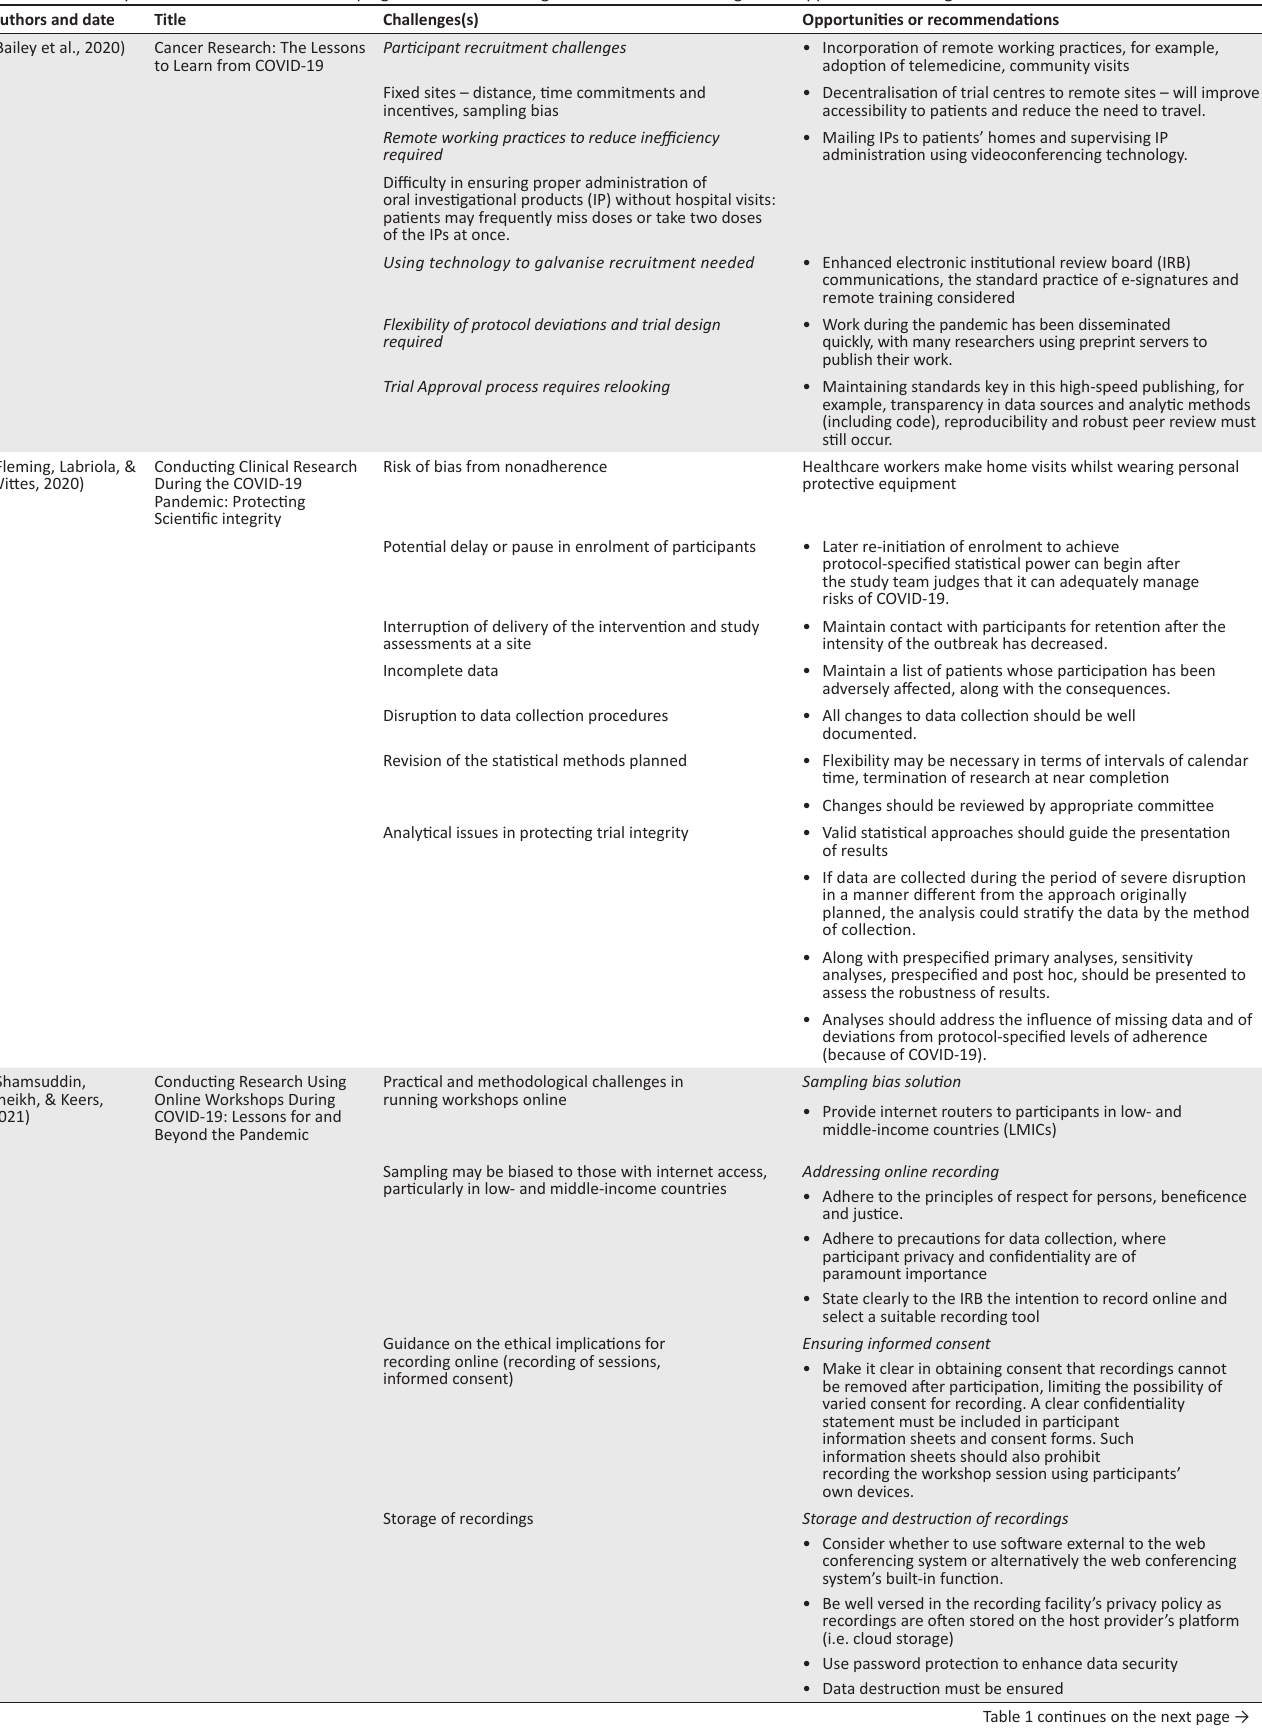
TABLE 1: Summary of studies included in the scoping review documenting clinical research challenges and opportunities during